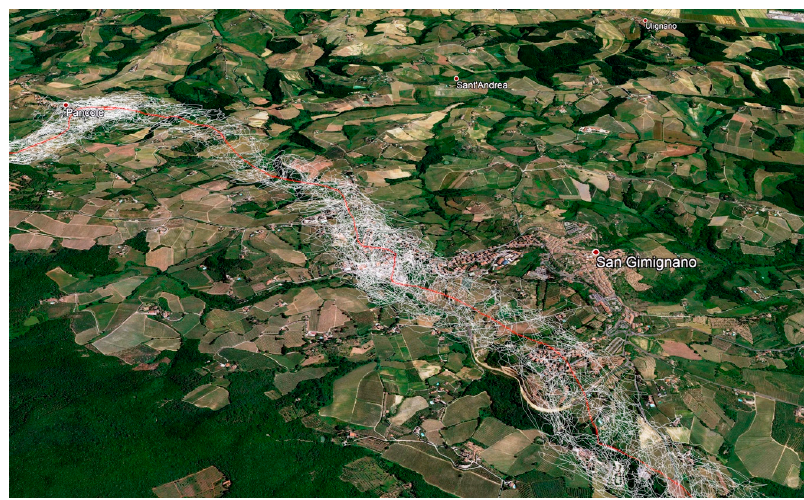
Figure 21. ( a ) Pitch oscillations vs. time registered by the IMU during flight ISM-HAB #3. ( b ) Low- pass filtered pitch oscillations signal at 27 km altitude.